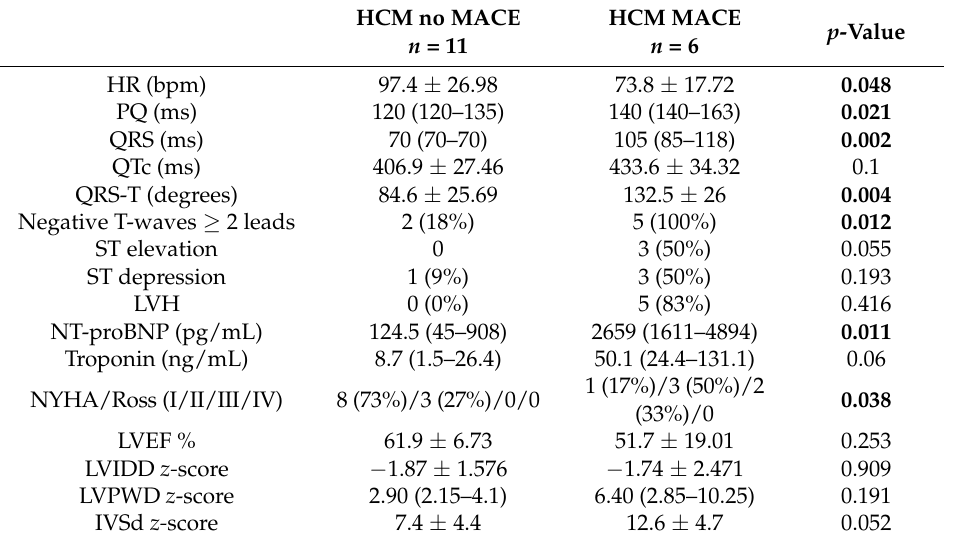
Table 4. Parameters associated with adverse outcomes in children with